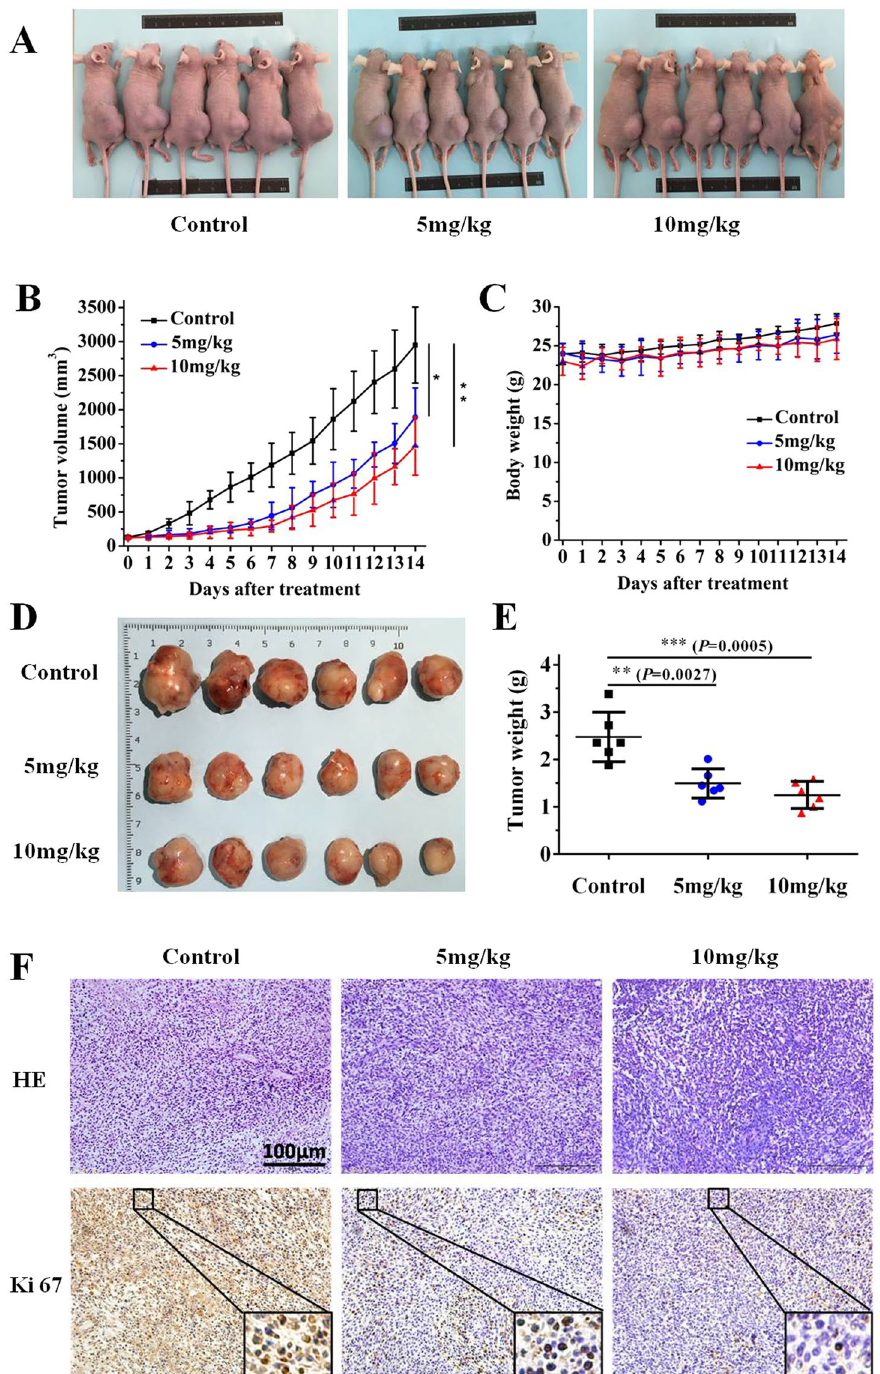
Figure 8. The antitumor effect of daphnegiravone D on human hepatoma Hep3B cells xenograft models. ( A ) The mice transplanted with human hepatoma Hep3B xenografts were randomly divided into three groups and given daphnegiravone D (5 mg/kg and 10 mg/kg, respectively, 1 per 2 day, i.p.) or vehicle for a period of 2 weeks. Representative photographs of the tumor xenografted nude mice. ( B ) The tumor volumes are expressed as mean ± SD (n = 6 per group). ( C ) The average body weight of each group is expressed as mean ± SD (n = 6 per group). ( D ) Representative photographs of the tumors at two weeks after daphnegiravone D treatment. ( E ) The weight of tumors harvested from mice are expressed as mean ± SD (n = 6 per group) at two weeks after daphnegiravone D treatment. ( F ) Histopathological examination of tumor tissues, as shown by H&E staining. The effects of proliferation-related biomarkers Ki-67 of Hep3B xenograft mice treated with daphnegiravone D were measured by immunohistochemistry. Scale bar, 100 μ m. Data are presented as means ± SD (n = 6), * P < 0.05, ** P < 0.01, *** P < 0.001 versus vehicle control